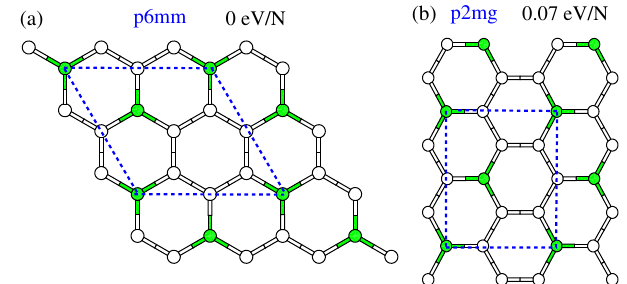
FIG. 3. (a) The most stable (lowest-energy) 2D structure (plane group: p6mm) of C 3 N from the 2D PSO simulations. (b) The second-lowest-energy 2D structure (plane group: p2mg) of C 3 N from the 2D PSO simulations. Dashed lines enclose the unit cells of the superstructures. The numbers denote the relative energies.